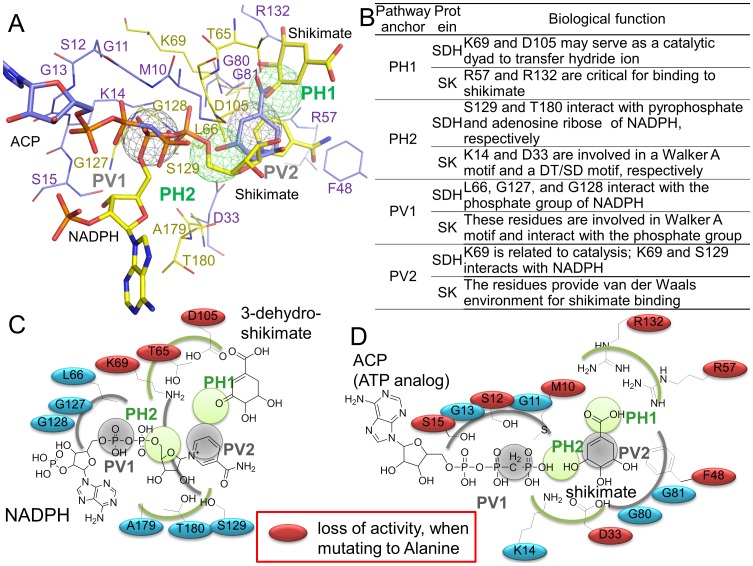
Relationship between the pathway anchors and biological functions.(A) Ligands of SDH and SK in the pathway site-moiety map. The ligands include shikimate and NADPH of SDH (PDB code 3PHI), and shikimate and ACP (ATP analog) of SK (PDB code 1ZUH [39], a shikimate kinase structure of Mycobacterium tuberculosis). (B) Pathway anchors for biological functions. Diagrams of the ligands and the pathway anchors for (C) SDH and (D) SK. Residues are colored in red if their mutations lead to loss of enzyme activity [14], [19], [30], [31].